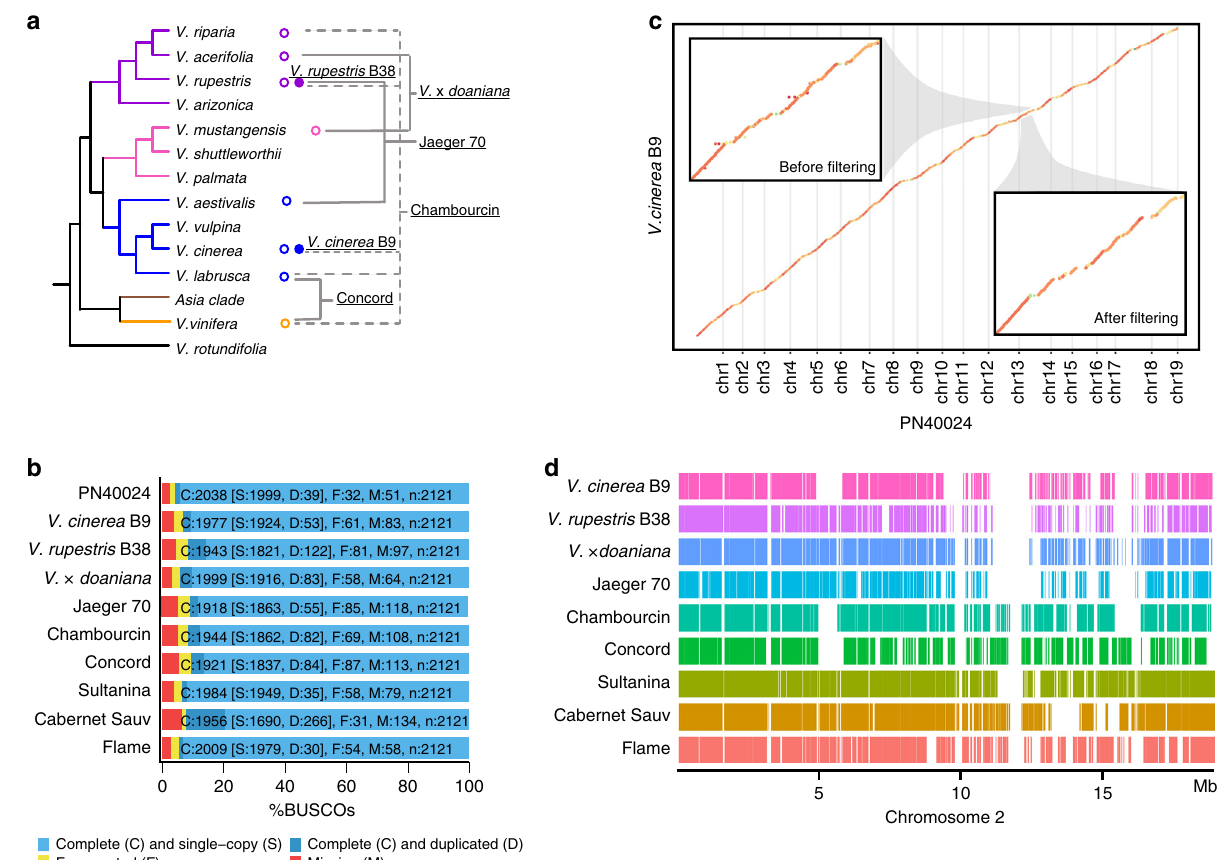
Complete (C) and single−copy (S)